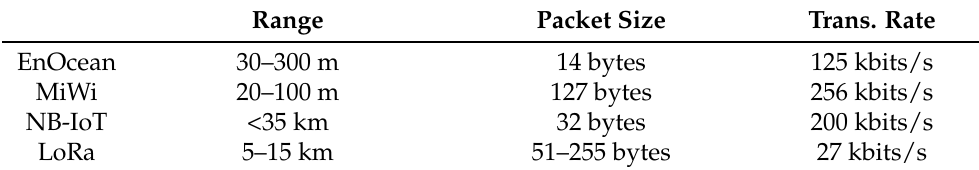
Table 6. Communication protocol comparison